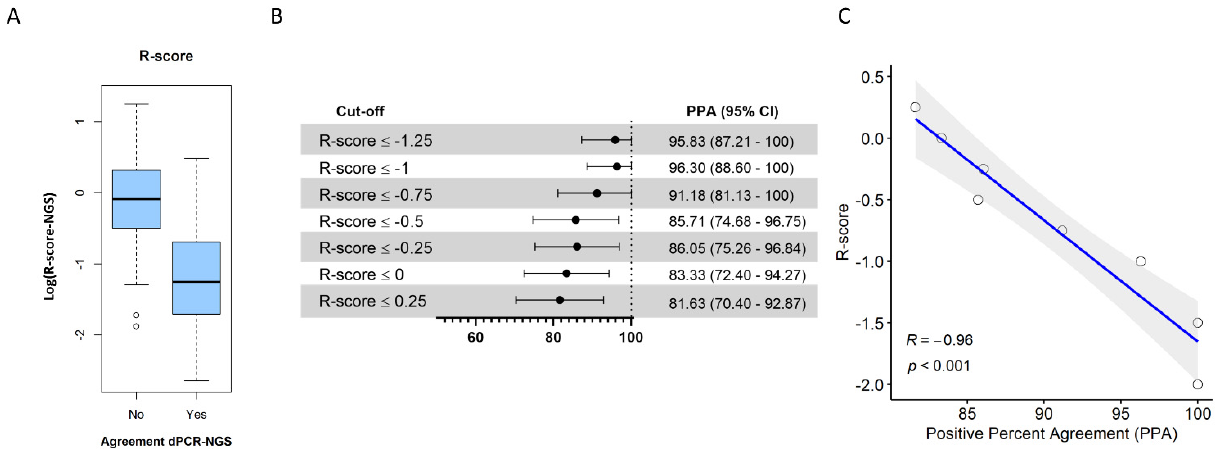
Figure 3. ( A ) R-score values in logarithmic scale in concordant and discordant samples (dPCR—NGS-Oncomine). R-score was calculated for each variant detected with Oncomine panel, using VAF and MAPD values from Ion Reporter (v5.10) analysis software. ( B ) Positive percent agreement (PPA) with corresponding 95% confidence interval (95%CI) between NGS-Oncomine and NGS-GeneReader according to R-score cut-off. The following arbitrary cut-offs for R-score were established: -1.25, -1, -0.75, -0.5, -0.25, 0, and 0.25, and PPA between both NGS platforms was estimated. ( C ) Correlation between PPA values and R-score cut-off values. As shown, there was a linear correlation between PPA and the R-score cut-off values; the lower the R-score, the greater the PPA. Abbreviations: R = Spearman correlation coefficient.